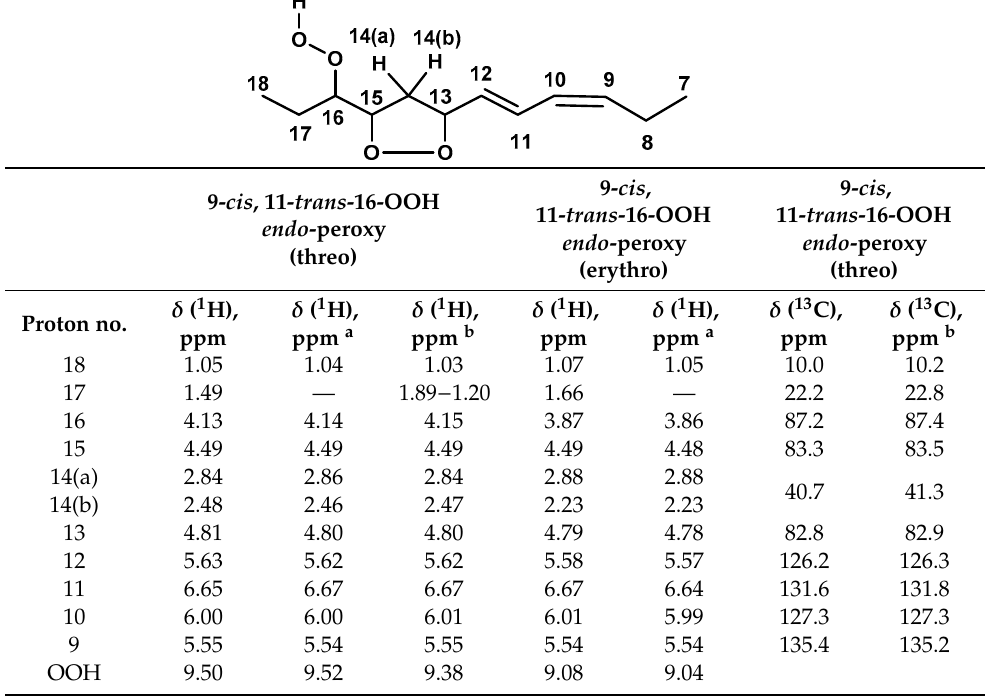
Table 2. Comparison of experimental 1 H- and 13 C-NMR chemical shifts of the 9- cis, 11 -trans -16-OOH diastereomeric endo -hydroperoxides of methyl linolenate of the present work and with the reported literature data with the use of isolated endo -hydroperoxides.